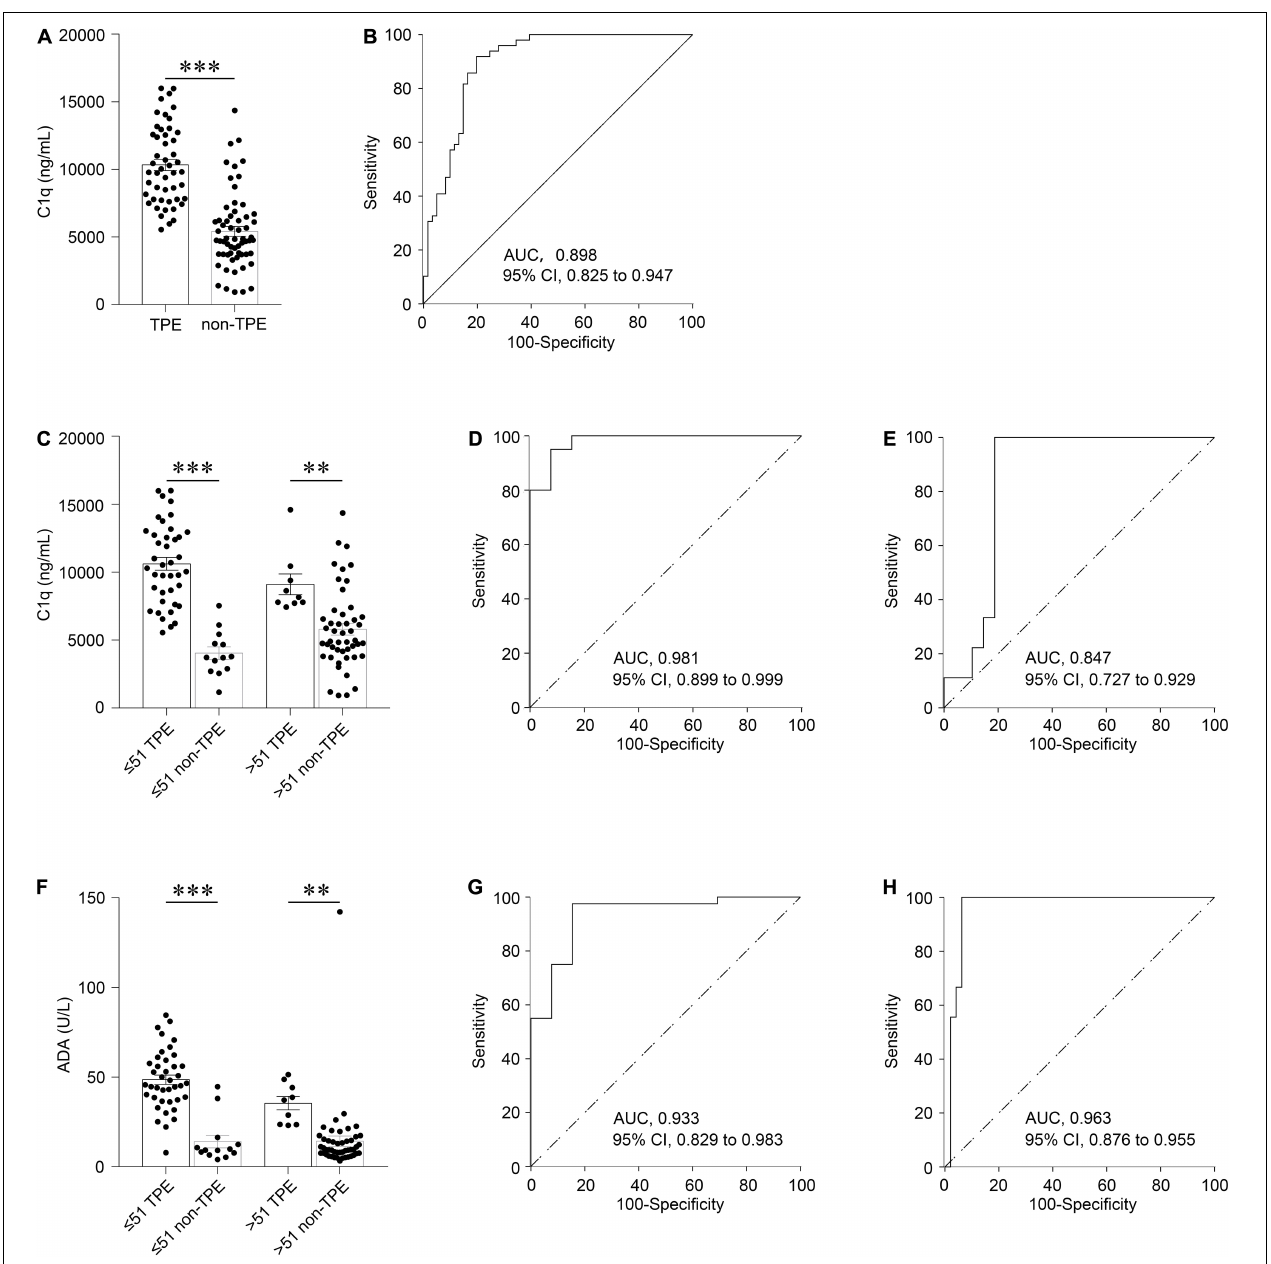
FIGURE 1 | Diagnostic accuracy of C1q and ADA in PF for TPE according to different ages. Comparison of C1q level in TPE and those in non-TPE cases (A) . The ROC curves show the diagnostic value of C1q in all patients (B) . Comparison of C1q in TPE and those in non-TPE cases according to age (C) . The ROC curves show the diagnostic value of C1q in younger patients (D) and older patients (E) , respectively. Comparison of ADA in TPE and those in non-TPE cases according to age (F) . The ROC curves show the diagnostic value of ADA in younger patients (G) and older patients (H) , respectively. ∗∗ P < 0.01, ∗∗∗ P <